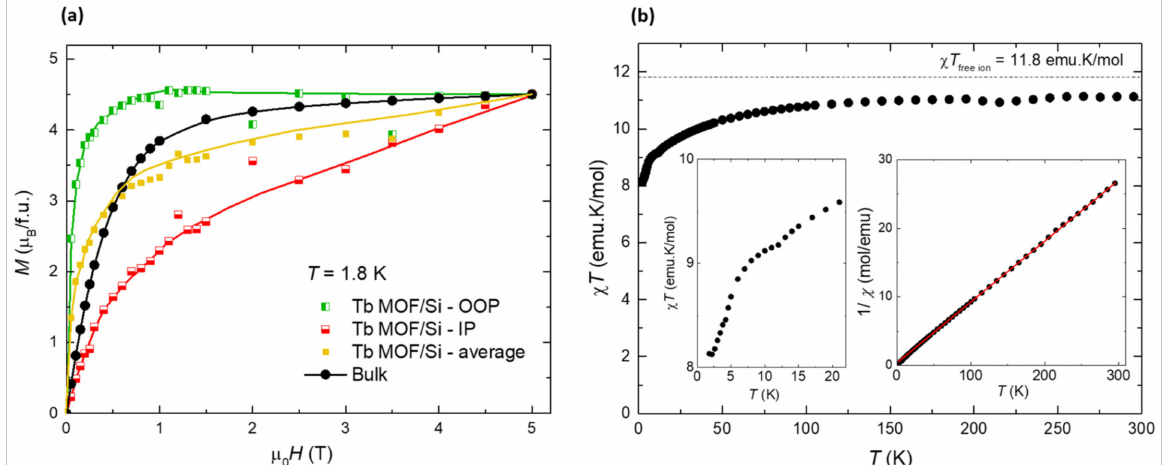
Figure 8. SQUID magnetic characterization of Tb-2D MOF of ( 1 ). ( a ) Field-dependence of the magnetization at T = 1.8 K for the bulk material, and flakes deposited on silicon, with the field applied in-plane (IP) and out-of-plane (OOP) with respect to the substrate, ( b ) temperature dependence of the susceptibility-temperature product, at H = 1 kOe, for the bulk. Inset: detail of the χ T ( T ) curve at low-T; also, 1/ χ curve and fit to a Curie-Weiss